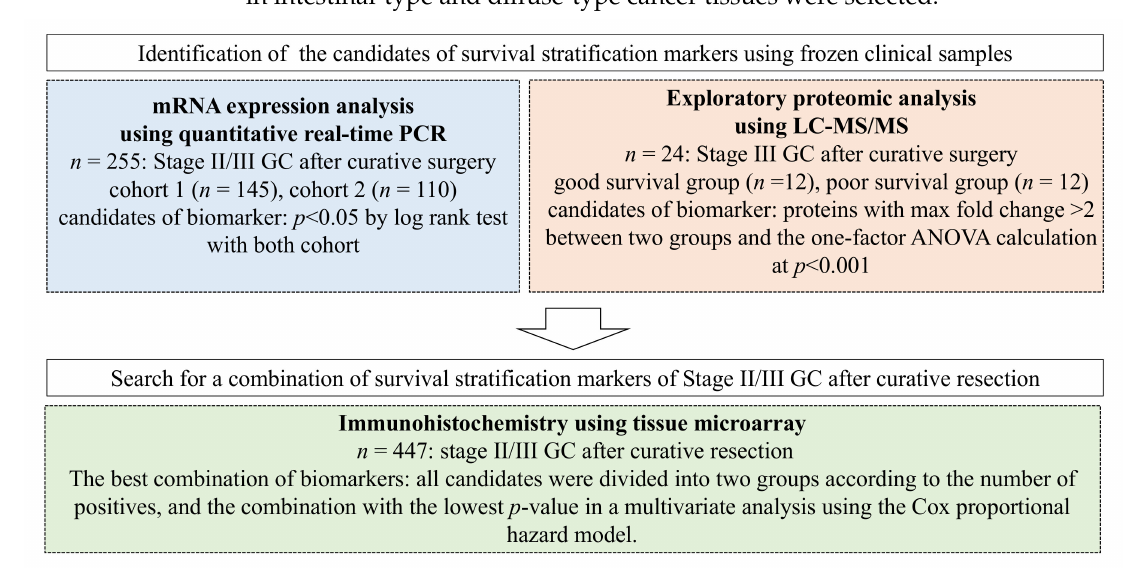
Figure 1. Overview of the strategy for identifying the best combinations of survival risk stratifica- tion markers using quantitative polymerase chain reaction (qPCR), liquid chromatography-mass spectrometry (LC-MS)/MS, and immunohistochemistry (IHC) using tissue microarrays